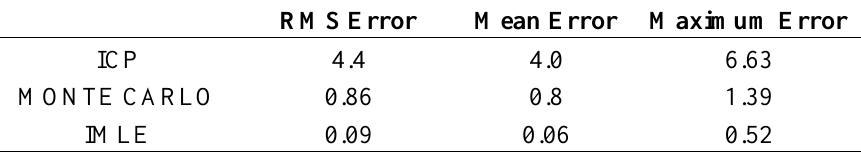
Table 1. The position error statistics